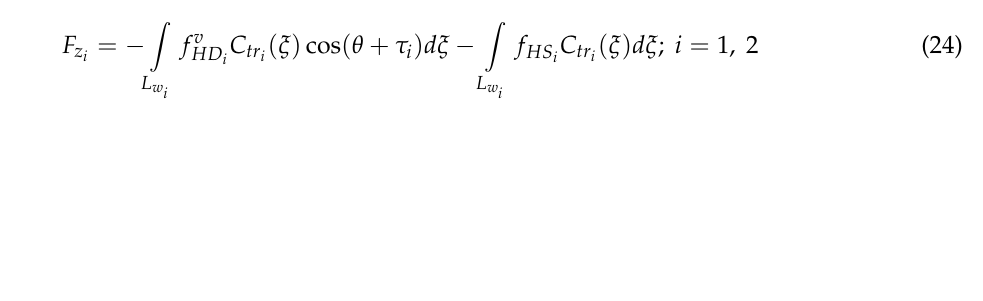
Figure 5. The steps and transom position.